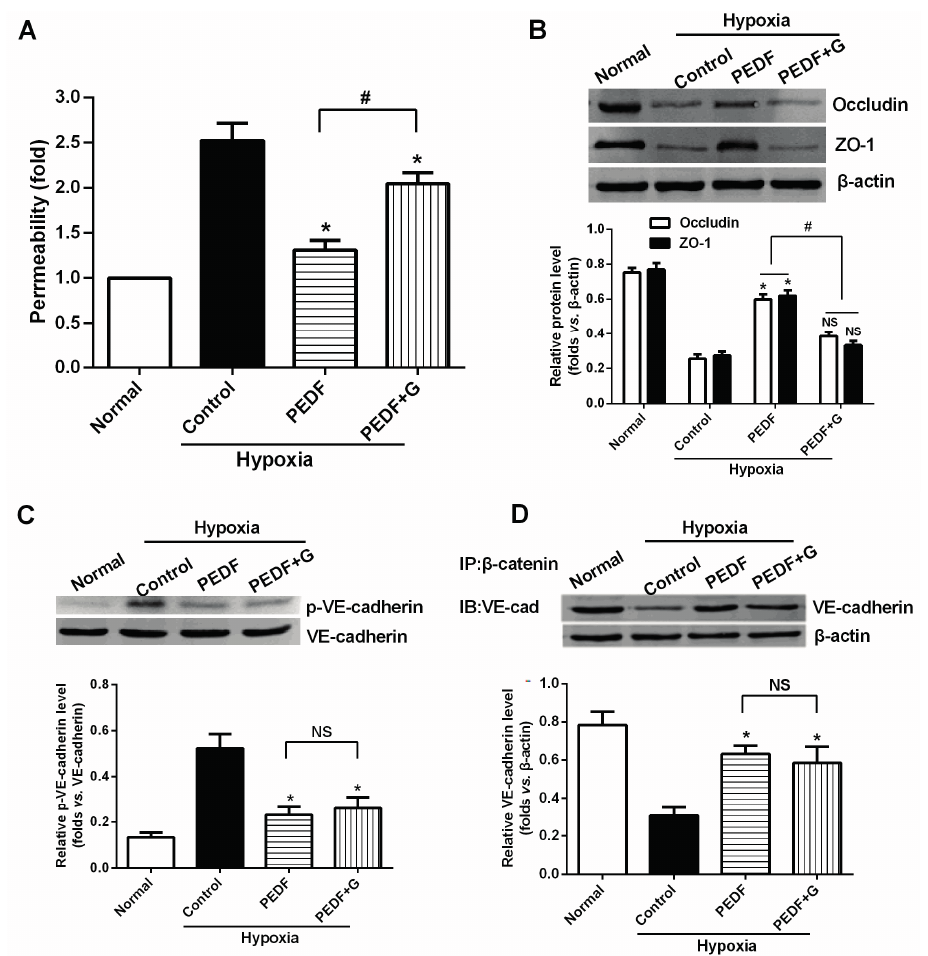
Figure 6. PEDF inhibits hypoxia-induced RAEC permeability through PPAR γ -dependent tight junction (TJ) production. ( A ) Endothelial permeability determination. PEDF’s effect PPAR γ inhibitor GW9662. Data are expressed as the mean ± SD ( n = 6). * p < 0.05 vs. the control group, # p > 0.05; ( B ) Western blot determination of TJs (occludin and ZO-1). * p < 0.05 vs. the control group, # p < 0.05; NS, p > 0.05 vs. the control group ( n = 3); ( C ) Western blot determination of VE-cadherin/VE-cadherin tyrosine phosphorylation. * p < 0.05 vs. the control group; NS, p > 0.05 ( n = 3); and ( D ) Co-immunoprecipitation